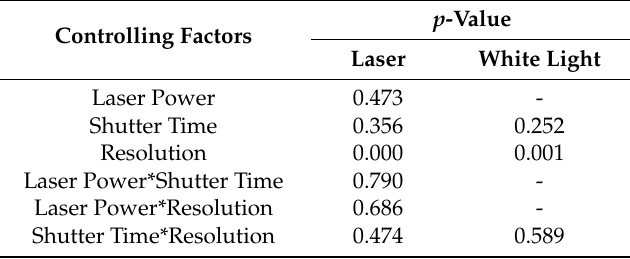
Table 5. p -Values using ANOVA for the laser-based and white light handheld scanners (scanning time). Table 6. p -Values using ANOVA for the laser-based and white light handheld scanners (triangle numbers). Controlling Factors Controlling Factors